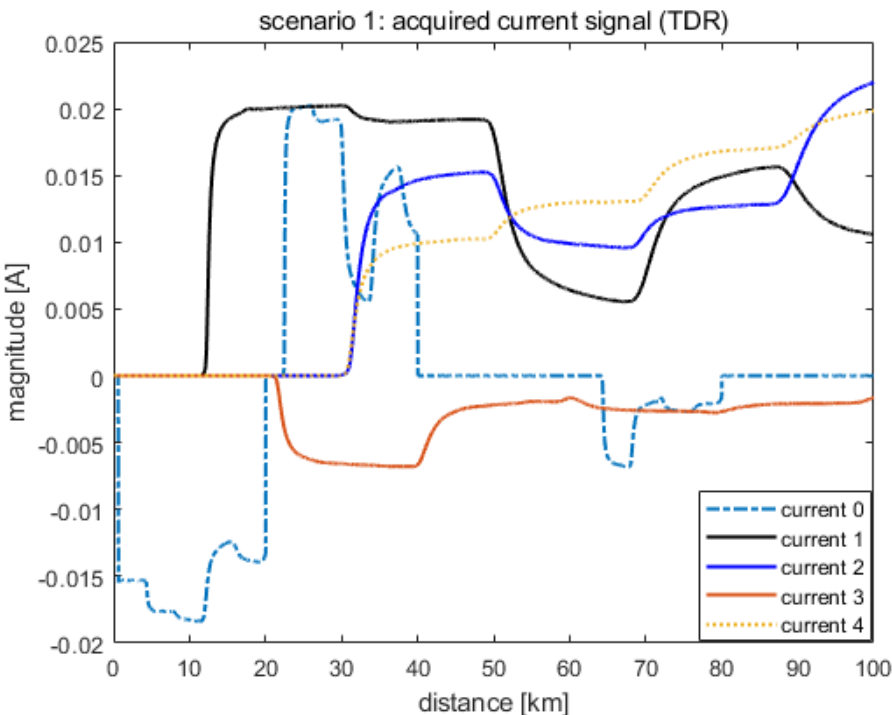
Figure 16. Fault localization results using TDR: scenario